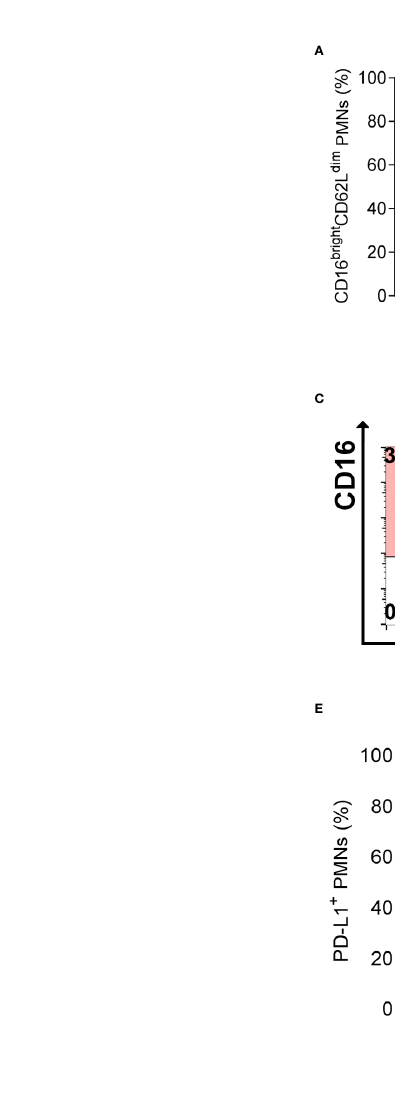
FIGURE 1 Activation status and PD-L1 + PMN frequencies in melanoma patients (MPs; fi lled dots) and healthy controls (HCs; open dots). Flow cytometry analysis of % CD16 bright CD62L dim cells gated on PMNs at baseline (A) and during nivolumab immunotherapy (B) . Representative fl ow cytometric panels illustrating scatter plot of CD16 bright CD62L dim cells in PMNs in melanoma patients (C) and healthy controls (D) . Flow cytometry analysis of PD-L1 + live cells gated on CD66b + CD11b + PMNs at baseline (E) and during nivolumab immunotherapy (F) . Data were expressed as percentage of PD-L1 positive cells compared to FMO controls, gated on CCR3 - CD66b + CD11b + neutrophils. The results were expressed as mean ± SD. * p<0.05; *** p < 0.001. Student ’ s T